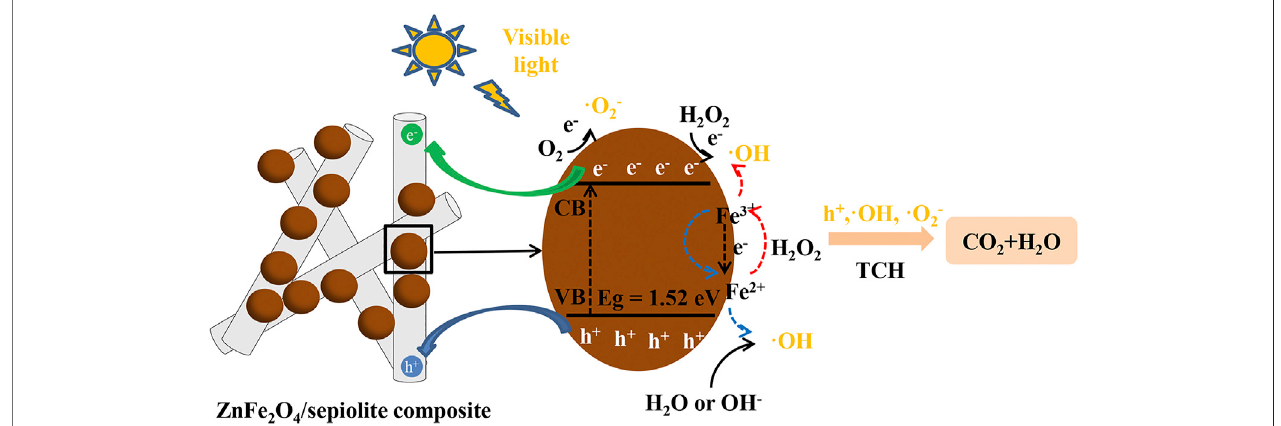
FIGURE 13 | Schematic diagram of possible mechanism.